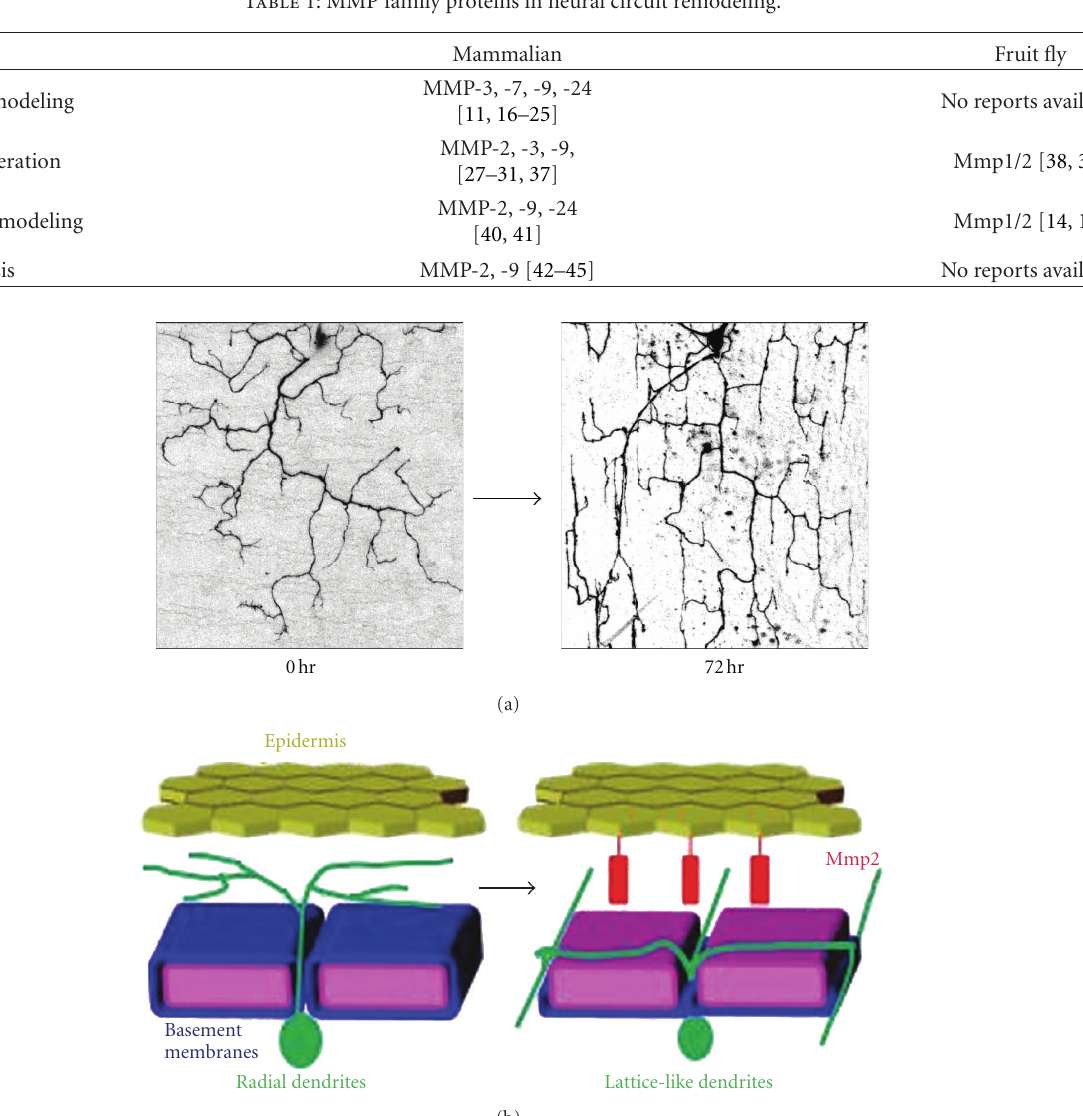
Figure 2: Dendrite reshaping in Drosophila sensory neurons is mediated by matrix metalloproteinases. (a) Dendritic pattern of a single class IV neurons in 0hr and 72 hr posteclosion adults. (b) Dendrites of Drosophila sensory neurons are rapidly reshaped within 24 hours after eclosion. This dendrite reshaping is promoted by the matrix metalloproteinase Mmp2-mediated degradation of the basement membrane, suggesting that proteolytic alteration of the extracellular matrix plays a fundamental role in remodeling of dendritic structures during reorganization of neuronal circuits. This model is predominantly based on data from